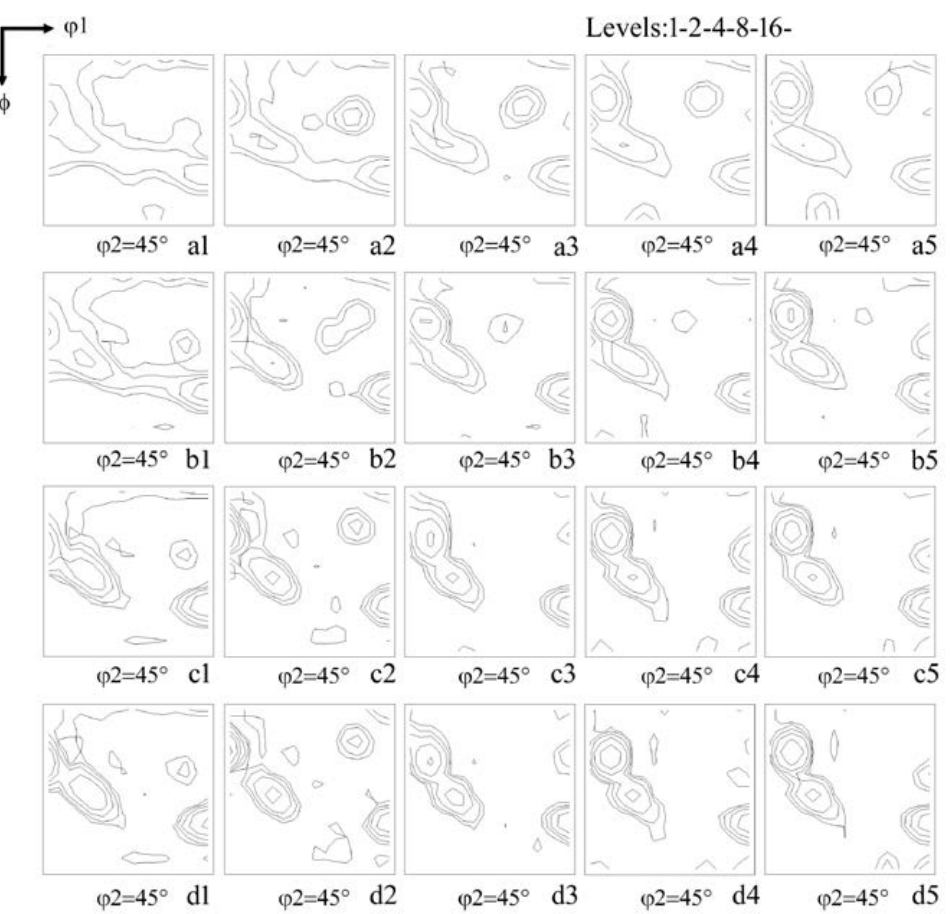
Figure 2. Calculated rolling deformation textures using reaction stress model under different ε 33 and α ij s , {110}<111> slip. ε 33 = − 0.36: ( a1 ) α ij s = 0.2; ( a2 ) α ij s = 0.4; ( a3 ) α ij s = 0.6; ( a4 ) α ij s = 0.8; ( a5 ) α ij s = 1; ε 33 = − 0.69: ( b1 ) α ij s = 0.2; ( b2 ) α ij s = 0.4; ( b3 ) α ij s = 0.6; ( b4 ) α ij s = 0.8; ( b5 ) α ij s = 1; ε 33 = − 1.1: ( c1 ) α ij s = 0.2;